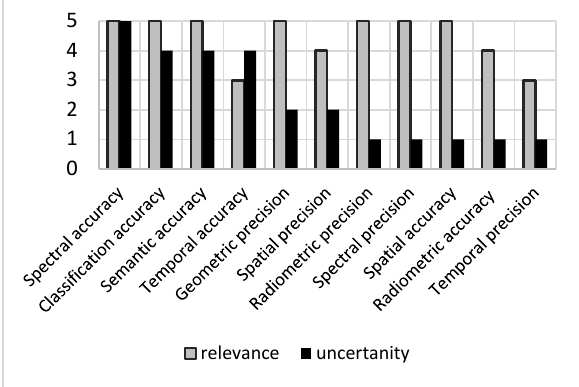
Figure 3. Relevance and uncertainty of accuracy dimensions in LPIS land cover